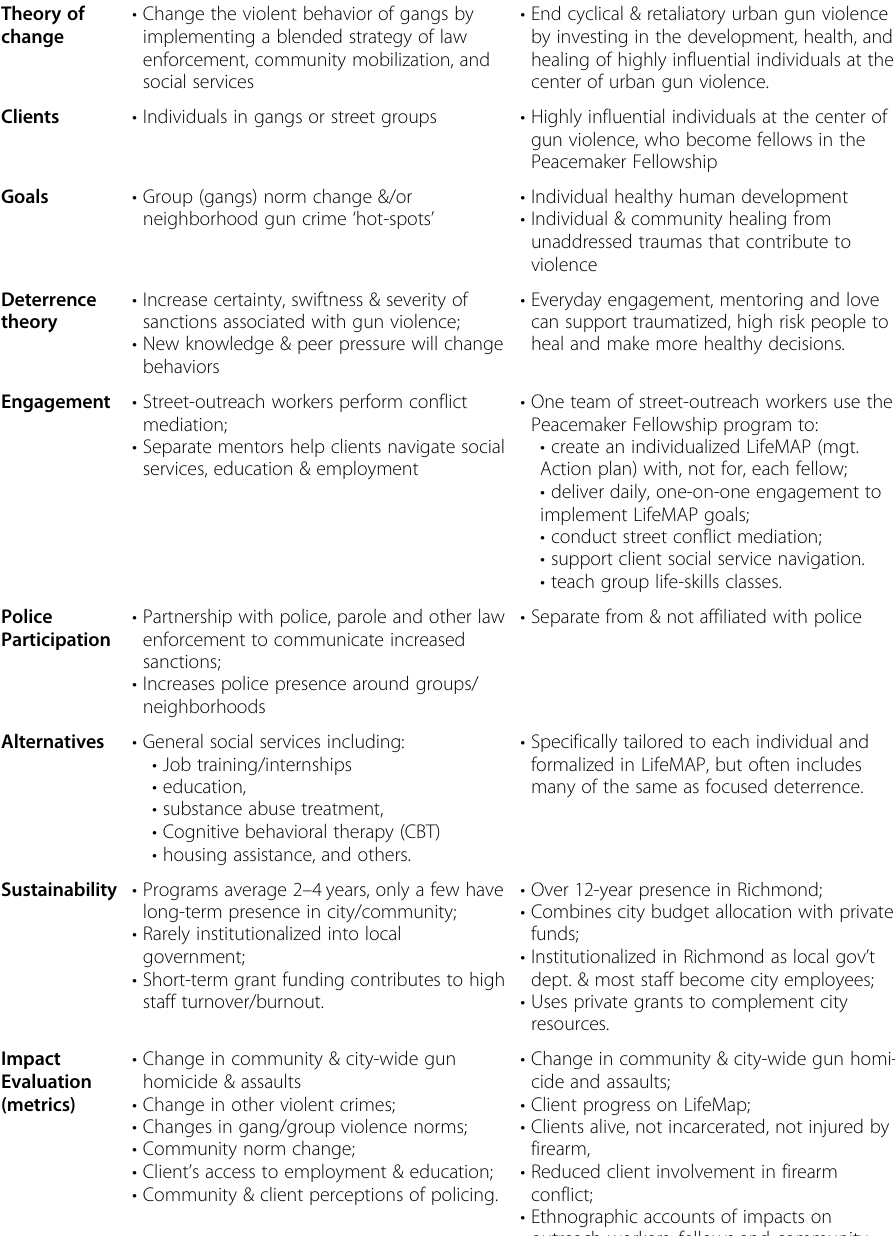
Table 1 Comparison of Focused Deterrence & Advance Peace Focused Deterrence Advance Peace (AP) Theory of